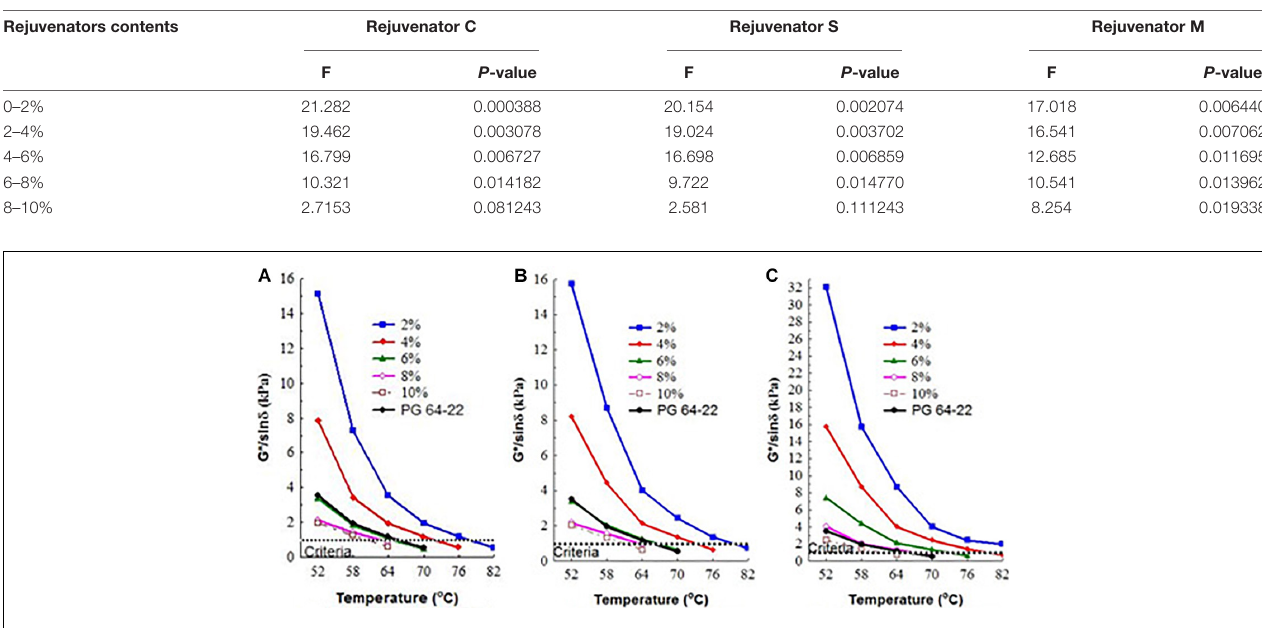
FIGURE 7 | Rutting resistance factors for the recovered bitumen with different contents of C, S, and M rejuvenators. (A) Rejuvenator C (based on corn oil). (B) Rejuvenator S (based on soybean oil). (C) Rejuvenator M (based on fuel oil).